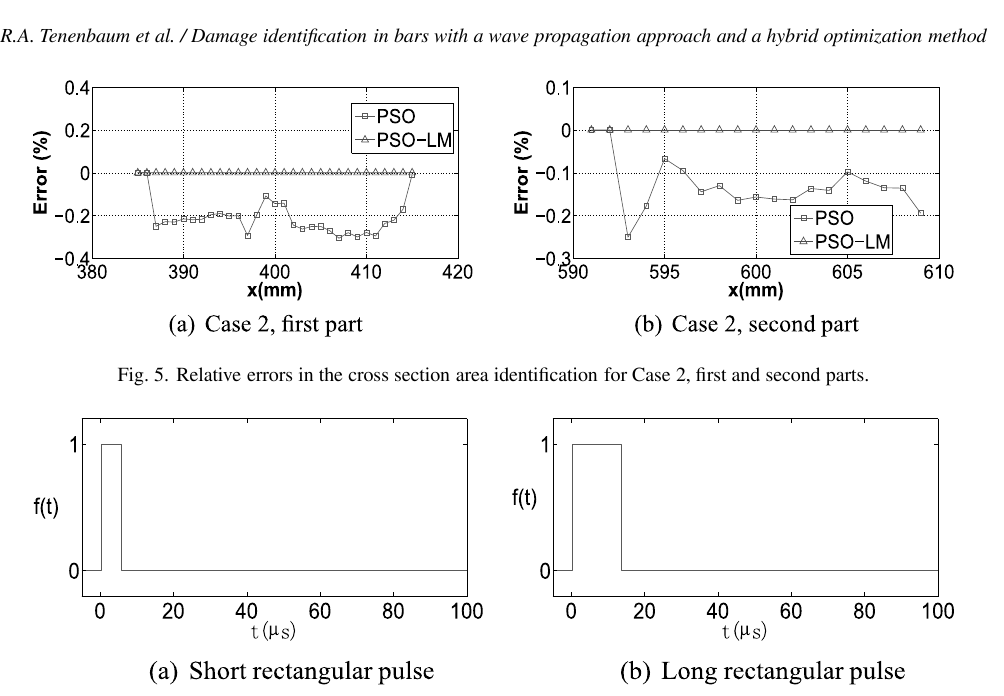
Fig. 6. Rectangular pulse